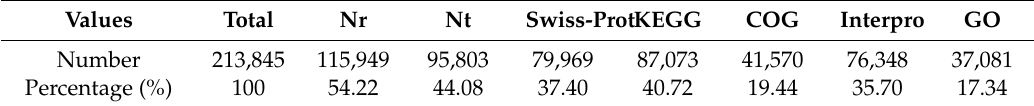
Table 1. Summary of the functional annotation of chrysanthemum unigenes. Values Total Nr